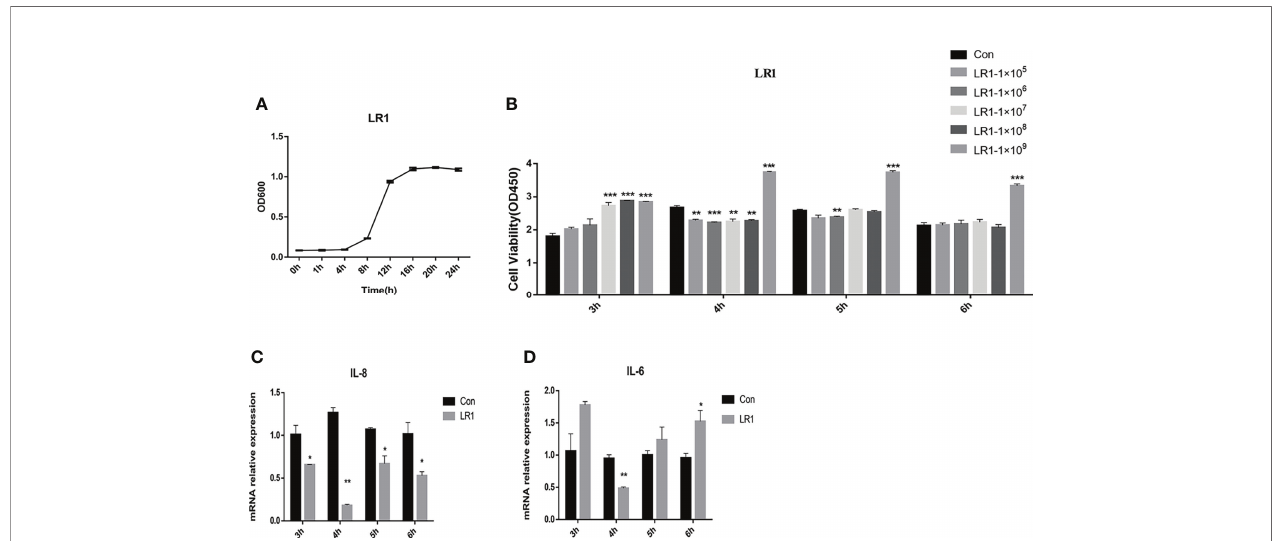
FIGURE 1 | Effects of L. reuteri LR1 on cell viability and in fl ammatory cytokine expression in IPEC-J2 cells. (A) The growth curve of L. reuteri LR1. (B) The effects of different levels of L. reuteri LR1 on the viability of IPEC-J2 treated for 3 h, 4 h, 5 h, and 6 h. (C) The relative gene expression of IL-8 after being treated with 1 × 10 9 cfu/ml L. reuteri LR1 for 3 h, 4 h, 5 h, and 6 h. (D) The relative gene expression of IL-6 after being treated with 1 × 10 9 cfu/ml L. reuteri LR1 for 3 h, 4 h, 5 h, and 6 h. Data presented as mean ± SEM ( n ≥ 3). * p < 0.05, ** p < 0.01, and *** p < 0.001 vs. the control